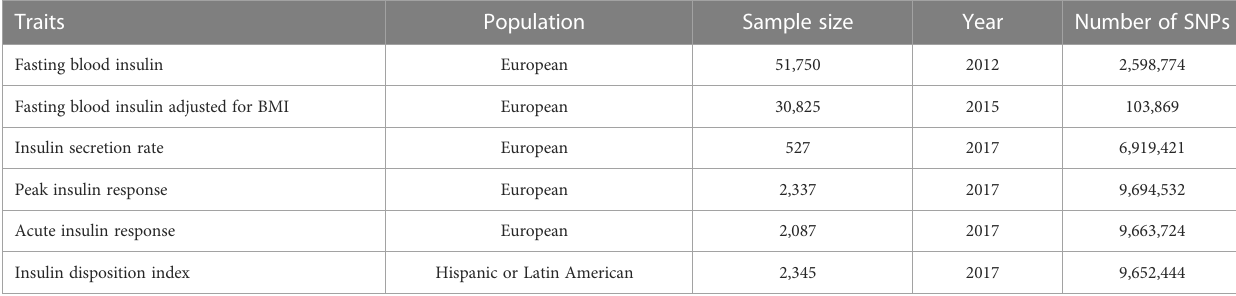
TABLE 1 Description of relevant GWAS